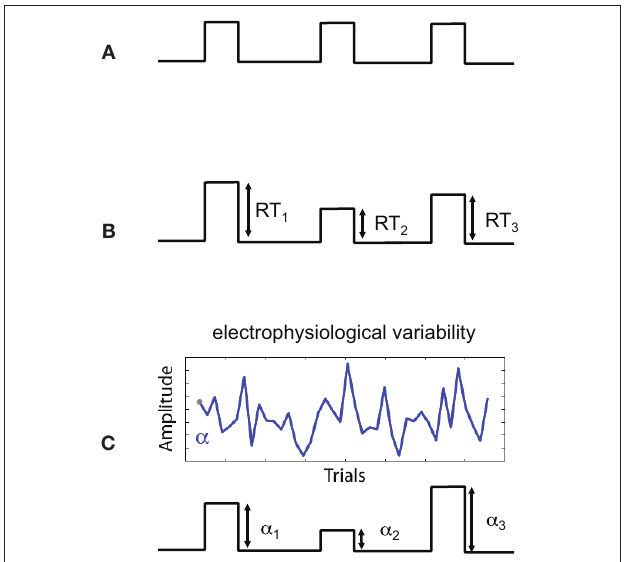
FIGuRE 1 | Sources of uncertainty in different regressor models. Shown are three regressor types (before convolution with the hemodynamic response function). (A) Regressor constructed from the onset times of the stimulus. The high certainty in this type of regressor is a result of stimulus times being set by the experiment and measured exactly. There is no uncertainty in the interpretation of amplitudes since they are constant. (B) Regressor constructed by modulating the stimulus onset times by response times (RTs). Measurement noise of RTs is low (i.e., RTs are high SNR measurements) however there is additional uncertainty (relative to case A ) in terms of the interpretation of the trial‑by‑trial variations in response time. (C) Regressor constructed by modulating stimulus by activity derived from electrophysiological variability. Sources of uncertainty include both measurement noise, due to the low SNR of the signal, as well as the interpretation of the trial‑to‑trial